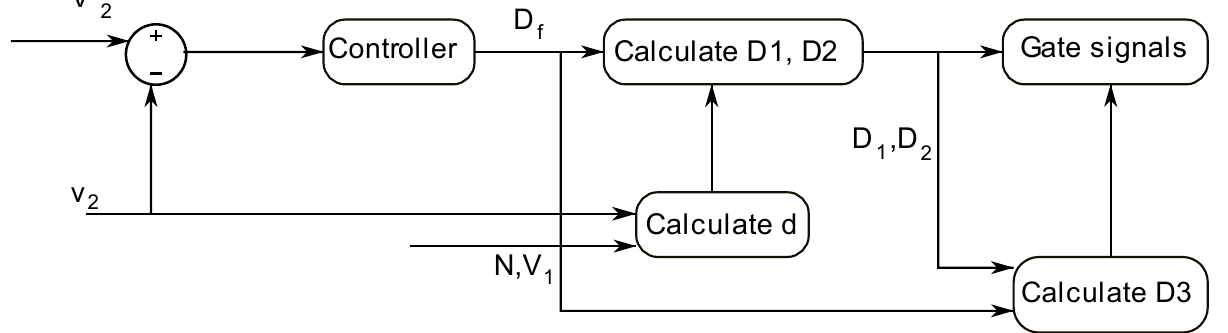
Figure 5. General control scheme to achieve minimum reactive power. Table 2. Global optimal duty ratios expressions using the control variable D f [22] . Voltage Gain Duty Ratio between Fundamentals D